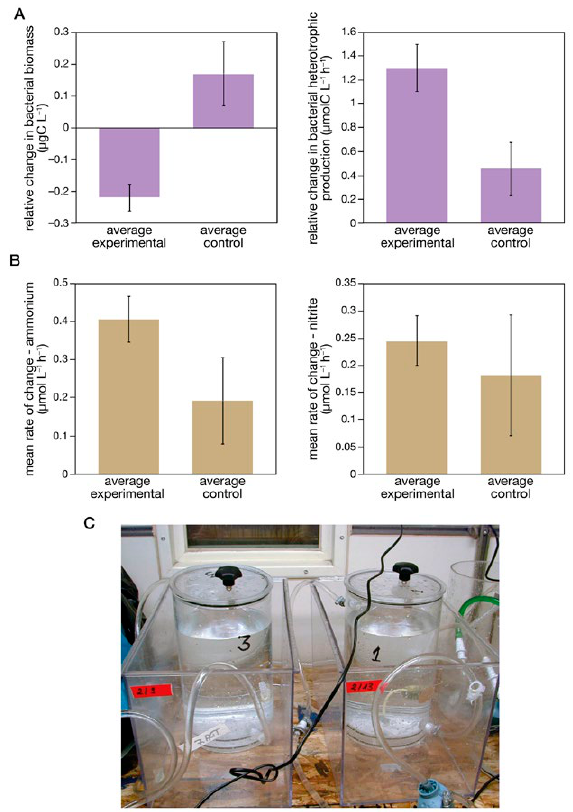
Fig. 6. – Experiments with the demosponge Stylocordyla chupach- ups (C) showing that sponges feed on bacteria, as bacterial abun- dance decreases (A left) and bacteria production increases (A right), but also enhance inorganic nutrient enrichment of water with both ammonium (B left) and nitrite (B right), increasing incubation